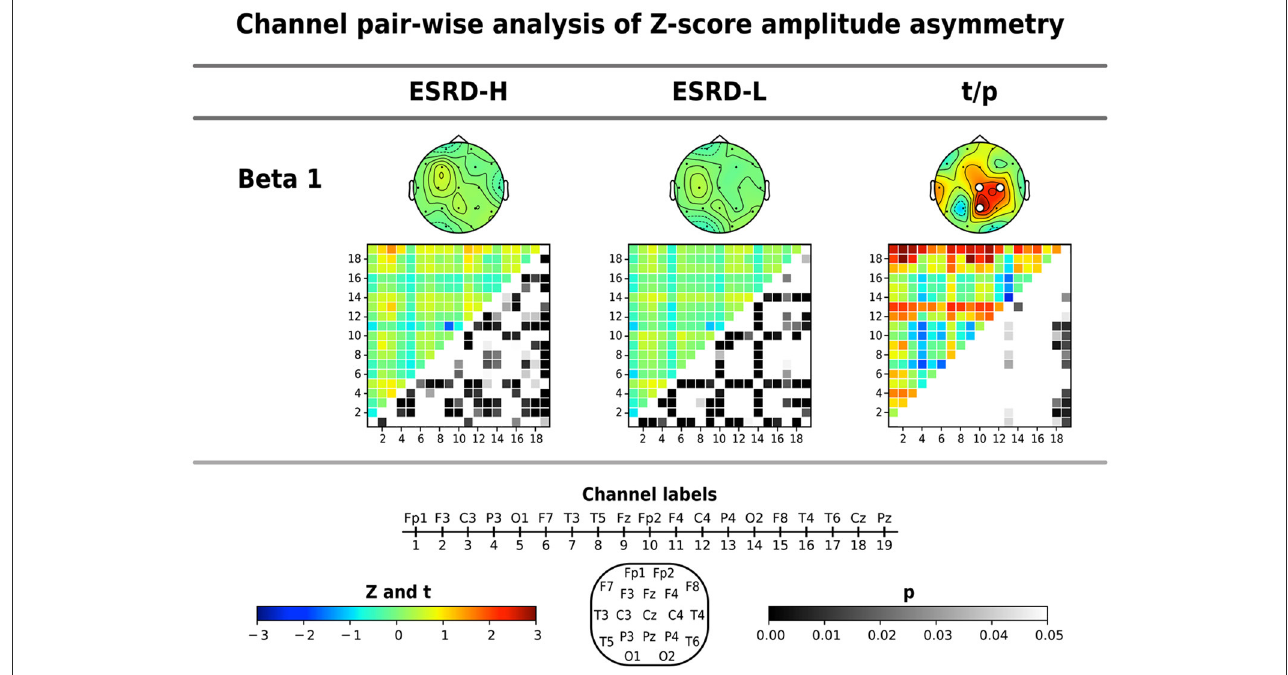
FIGURE4 Channel pair comparisons of Z-score amplitude asymmetry were performed by using permutation-based t -tests. The average Z-score and significant channel t -values are shown in the topographical maps. The respective amplitude asymmetry matrices (19 x 19 channels), in which the upper triangular part indicates the Z - or t -values (171 values) and the lower triangular part signifies their corresponding p -values (171 values), are also shown. Note that the p -values of upper triangular Z-scores were obtained through comparisons to zero using one-sample permutation tests. All values are represented by color bars, and the electrode channels are represented by